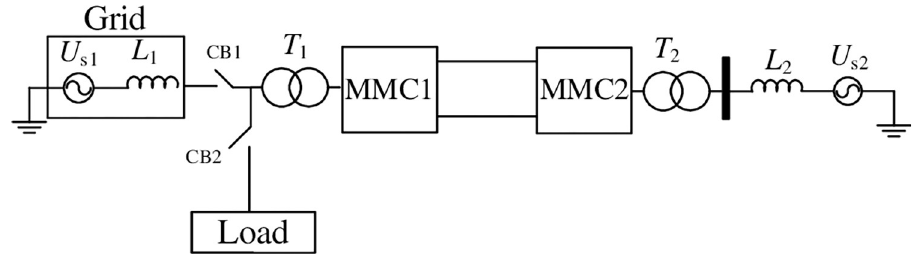
Fig 8. Simulation structure based on VSG